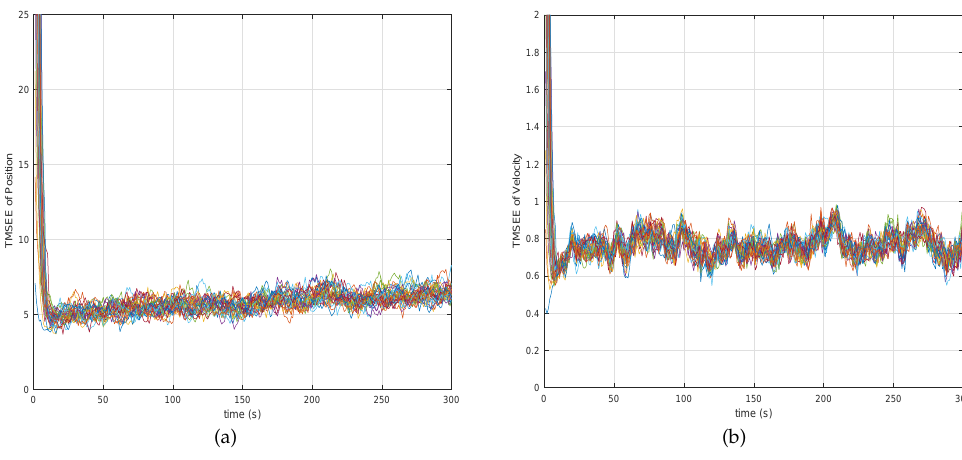
Figure 11. TMSEE of position and velocity of algorithm 1. ( a ) TMSEE of position; ( b ) TMSEE of